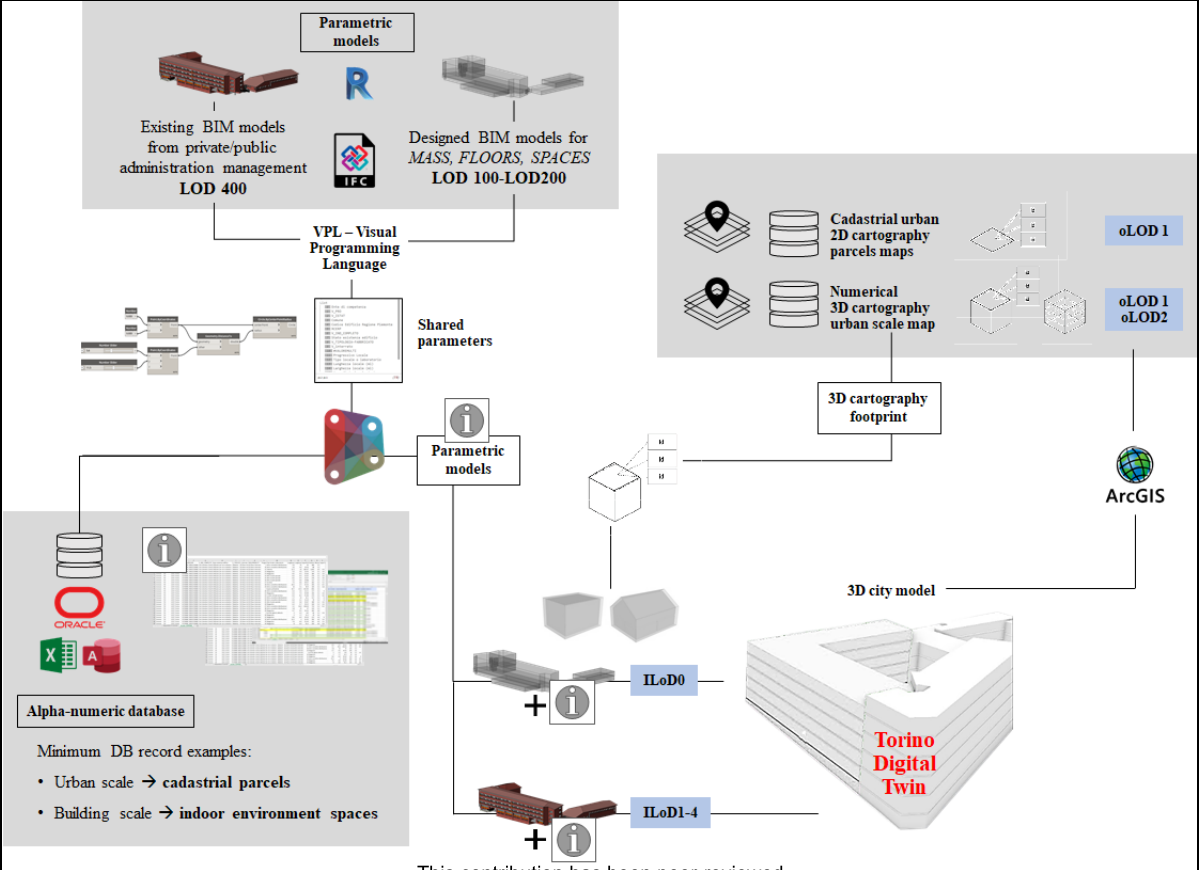
Figure 2. The schema of the proposed